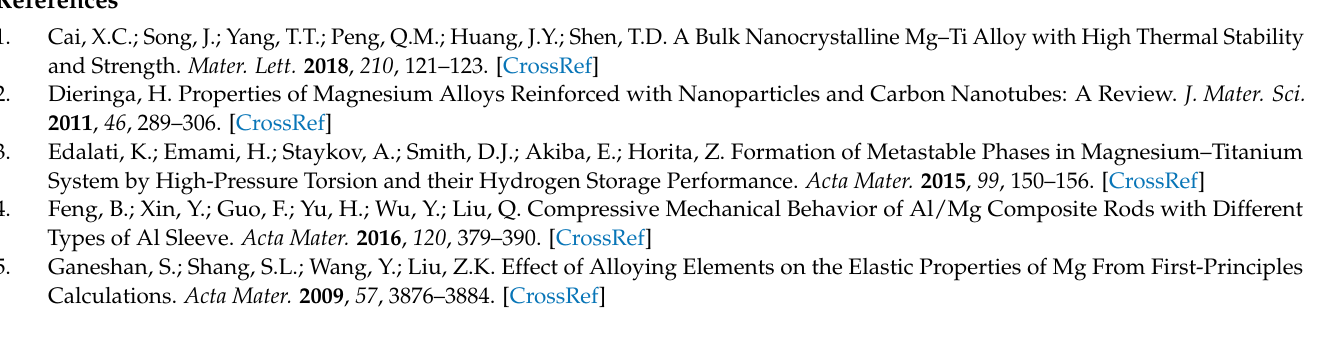
Table S2: The original nanoindentation data for line